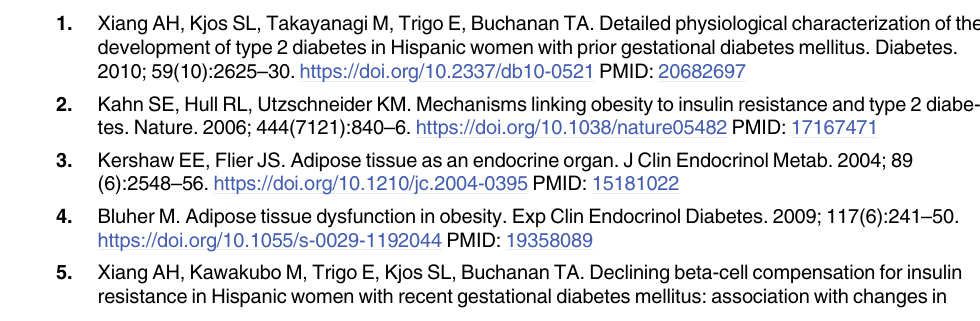
S1 Table. Intra- and inter- assay coefficients of variation